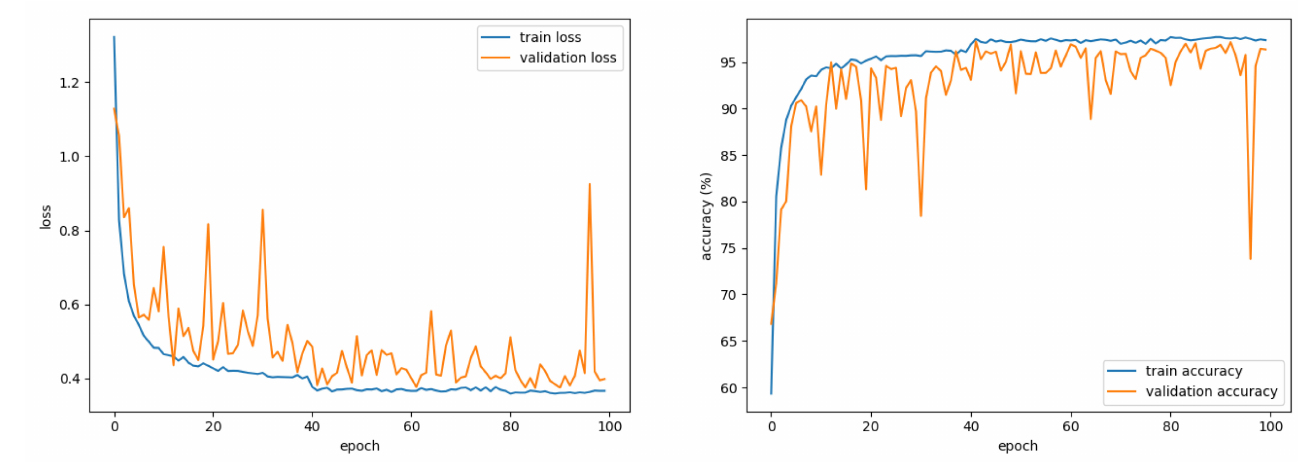
Figure 8. Learning curve of the 2-channel binarized convolutional neural network.